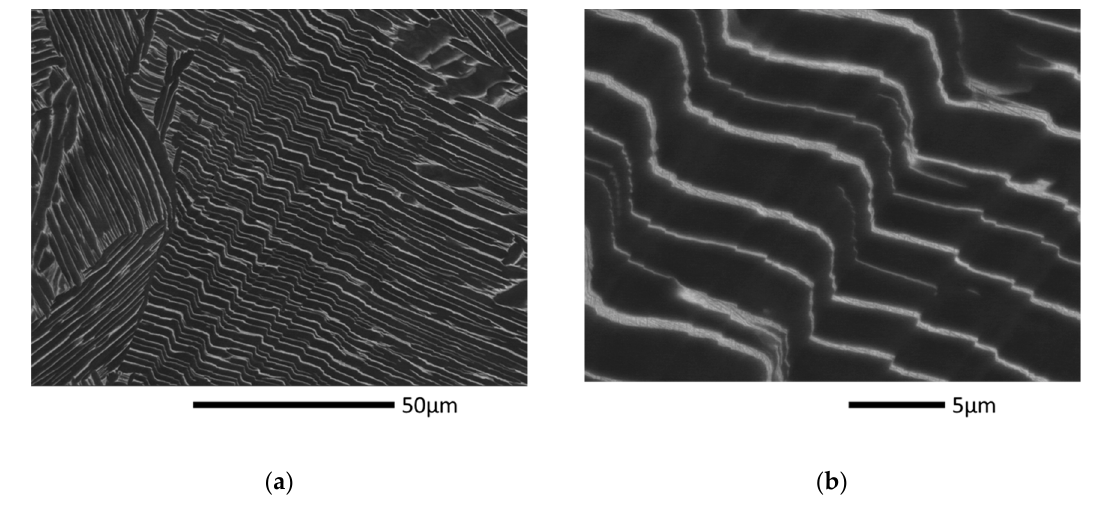
Figure 8. BSE images showing shearing at the α / β lamellae interfaces in the colony adjacent to the facet colored in blue Figure 7a: ( a ) low and ( b ) higher magnification.